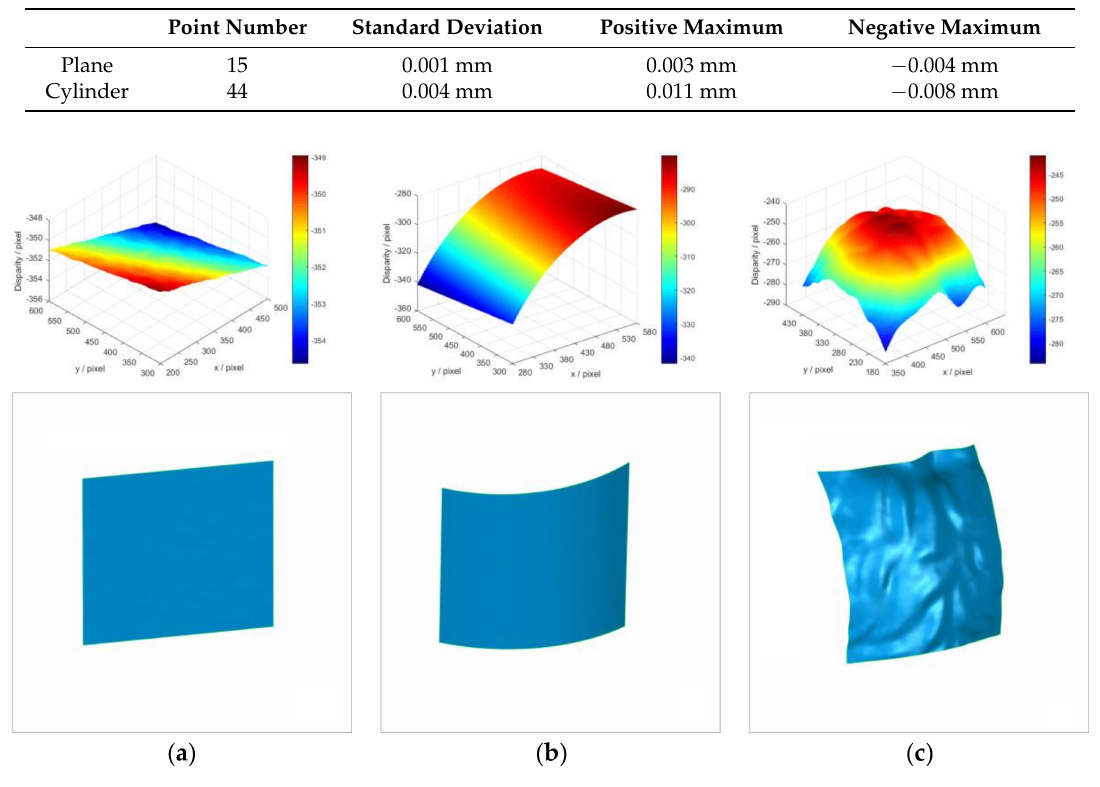
Figure 8. Measured disparity maps and corresponding 3D shapes, the disparity maps are listed on the up row and the corresponding 3D shapes are listed in the bottom row: ( a ) The ROI of plane; ( b ) The ROI of cylinder; and ( c ) The ROI of